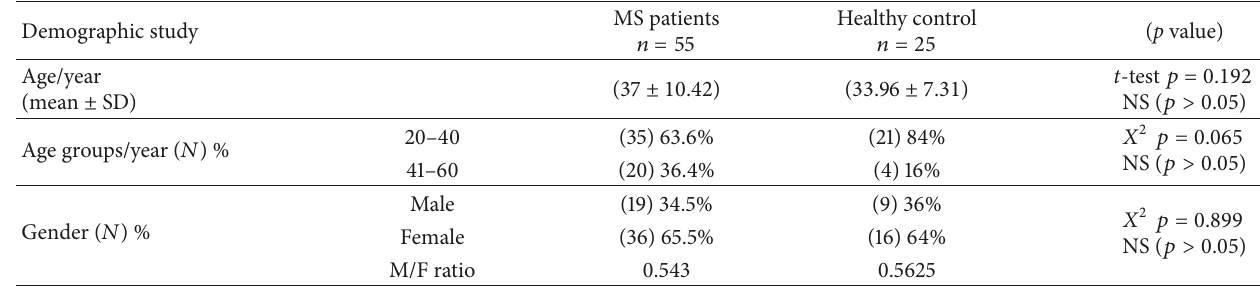
Table 1: Comparison between MS patients and controls using demographics study.